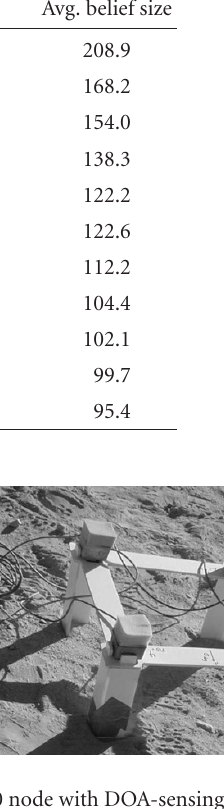
Figure 11: WINS 2.0 node with DOA-sensing microphone array. roads are shown in Figure 12. Vehicle maneuvers were con- fined to the roads shown although, by choice, the algorithms of this paper do not assume this knowledge. DOA sensing arrays were identical square arrays with 1 feet (0.305 m) on the side configured as shown in Figure 11 and on legs 8” o ff the ground. The zero-degree